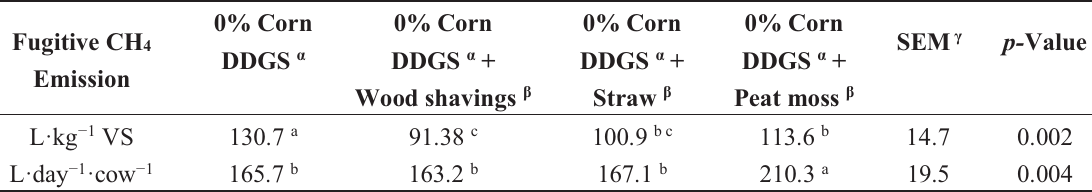
Table 5. Effects of including three bedding types (wood shavings, straw and peat moss) in dairy slurry from the controlled experiment (0% DDGS) on manure CH 4 emissions during 4 months of